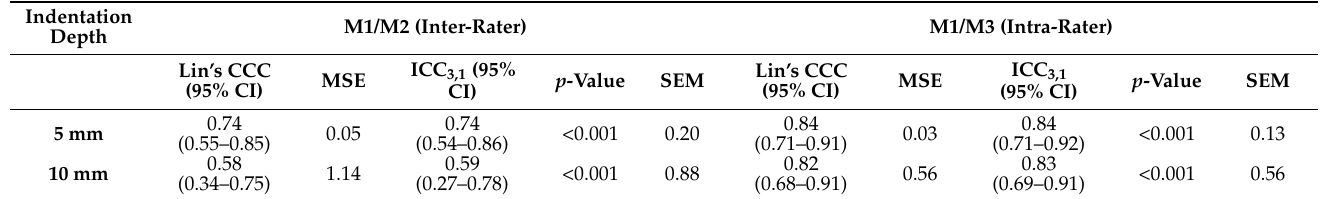
Table 3. Inter-rater and intra-rater reliability of the IndentoPro in measuring tissue stiffness.